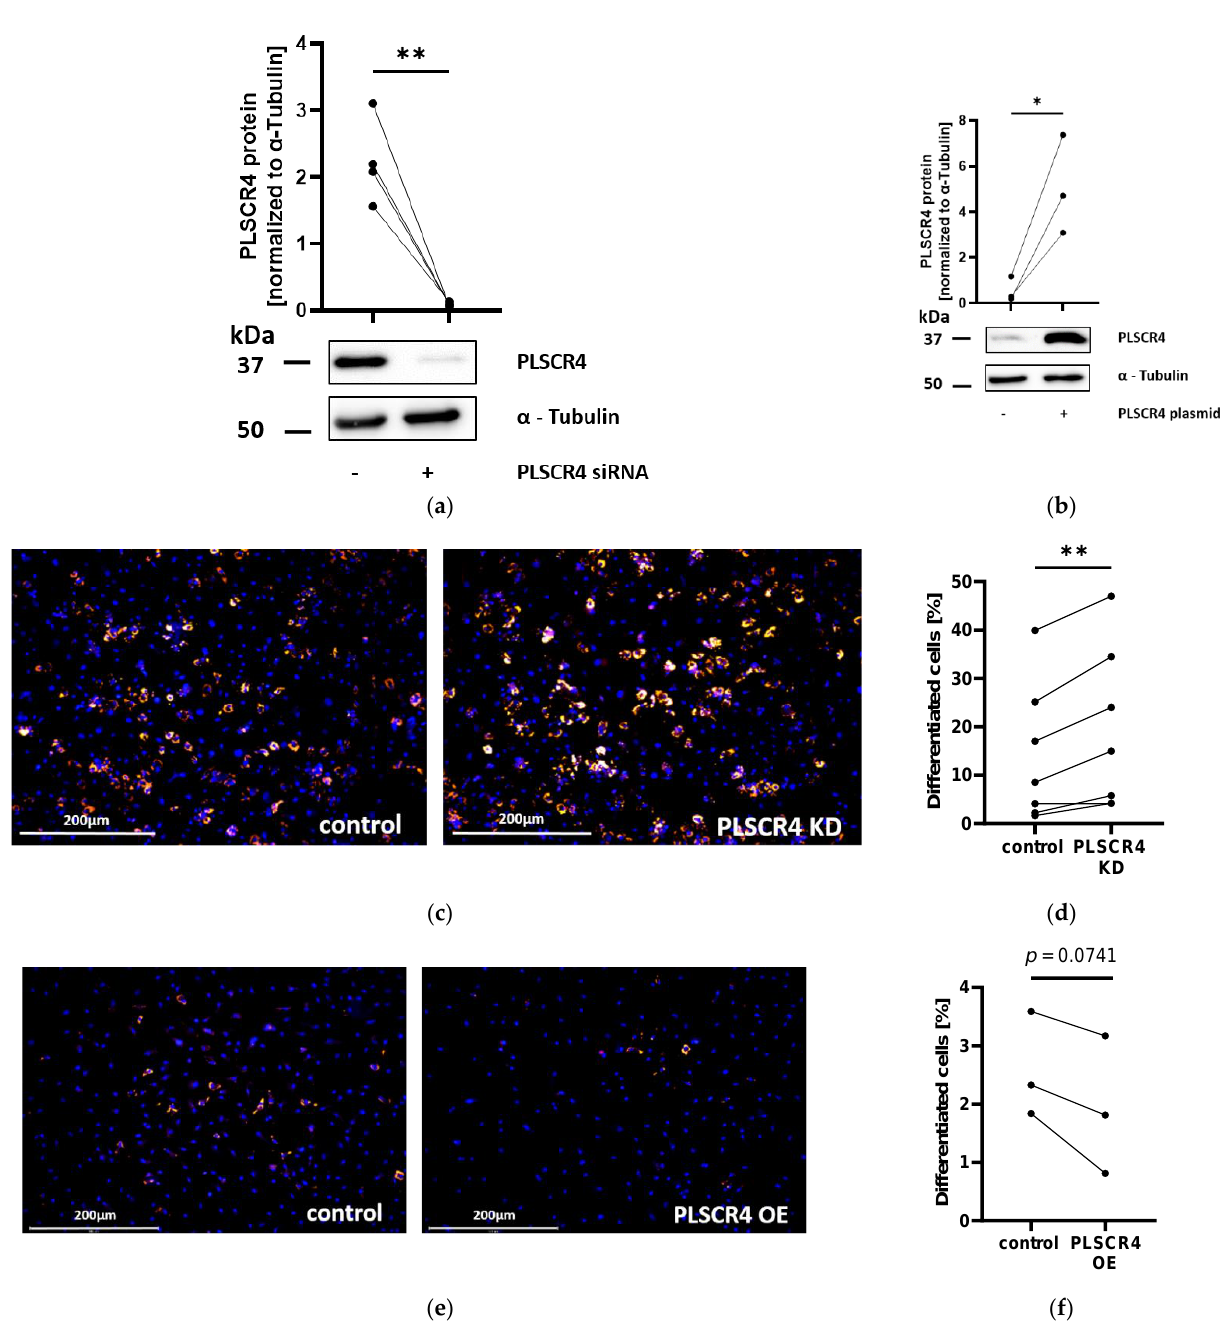
Figure 4. Effects of knockdown (KD) and overexpression (OE) of PLSCR4 on differentiation of APCs. ( a ) PLSCR4 KD: At protein level, PLSCR4 was reduced by 95.8% ± 15.0% (normalized to α -Tubulin; n = 4; p = 0.0077) in adipocyte progenitor cells. ( b ) PLSCR4 protein was upregulated 8.23 ± 1.79-fold (normalized to α -Tubulin; n = 3; p = 0.0446) in APCs transfected with a PLSCR4 expression plasmid. ( c ) Hoechst nuclear staining (blue) and Nile Red lipid staining (red) in control and PLSCR4-siRNA-transfected APCs after 8 days in adipogenic medium. ( d ) The differentiated cell fraction in PLSCR4 KD cells was increased 1.37 ± 0.09-fold ( n = 7; p = 0.0056). ( e ) Hoechst nuclear staining (blue) and Nile Red lipid staining (red) in APCs with or without PLSCR4 OE after 8 days in adipogenic medium. ( f ) The fraction of differentiated cells decreased by 25.3% ± 7.3% ( n = 3; p = 0.0741). Matched results were visualized via lines between data points (control versus PLSCR4 KD/OE). p -values were determined via paired t -test (* p < 0.05, ** p < 0.01). PLSCR4, phospholipid scramblase 4.